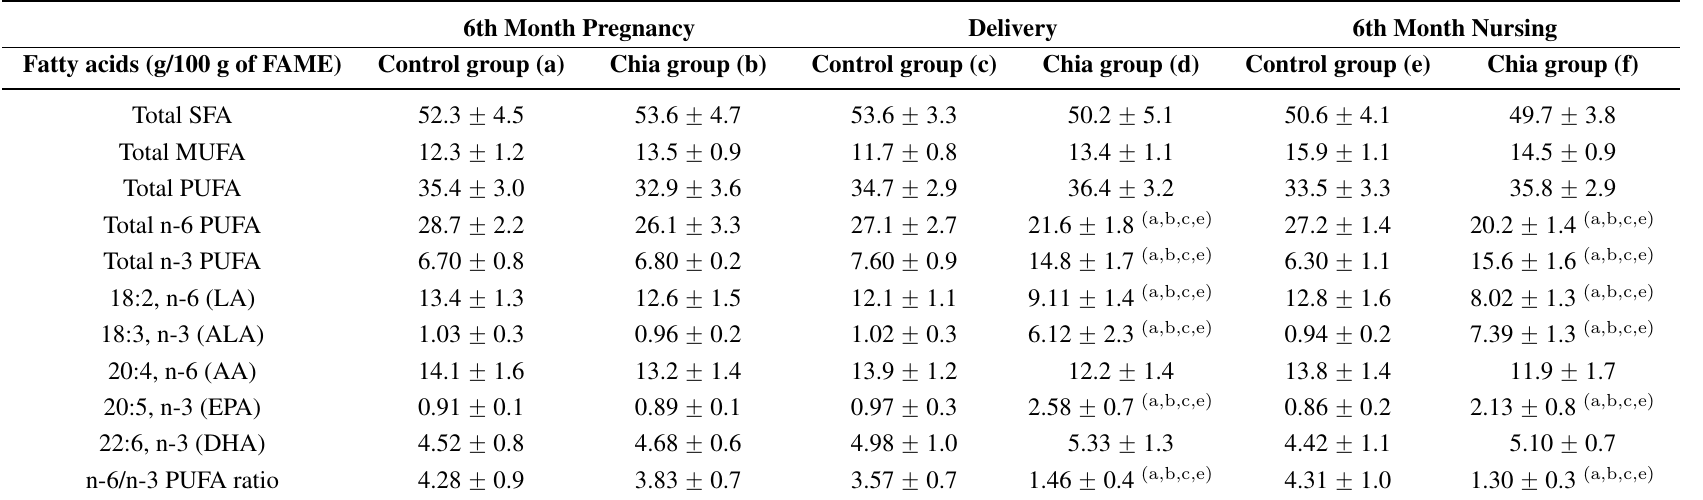
Table 3. Fatty acid composition of erythrocyte phospholipids of mothers during pregnancy and